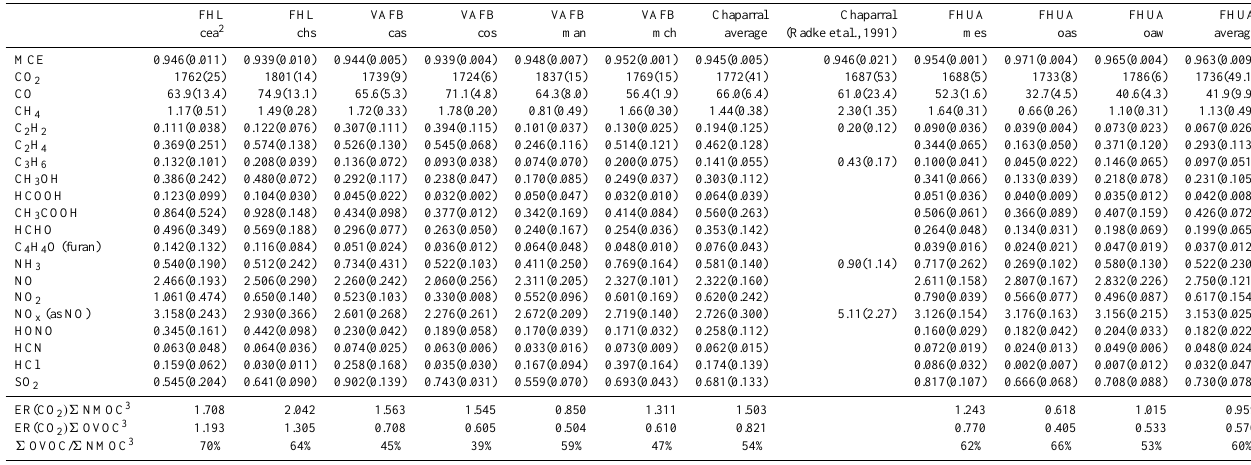
1 Value in brackets corresponds to (1 σ) standard deviation.